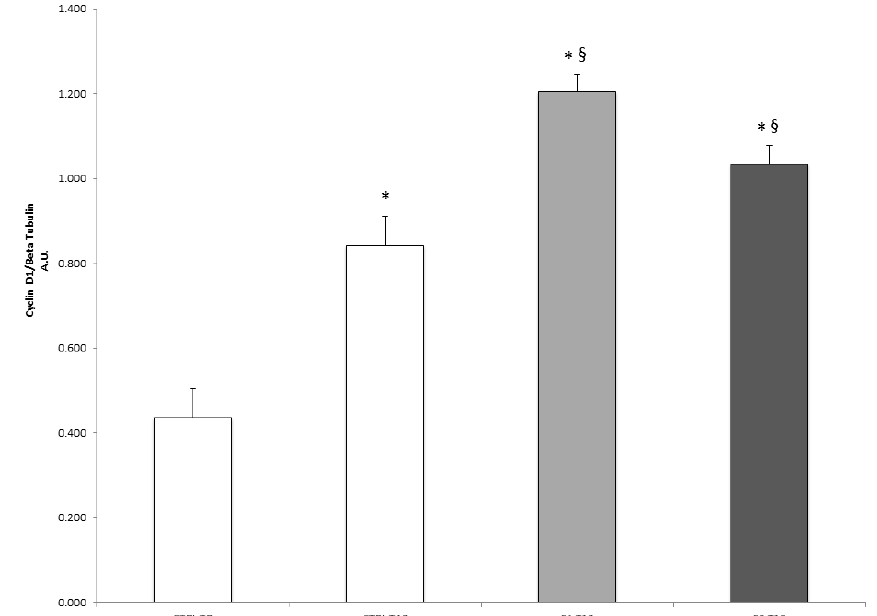
Figure 4. Effect of S1 and S2 on the proliferative marker cyclin D1 in HCEpiC cells. The graph shows the cyclin D1 protein levels in HCEpiC cells treated with S1 or S2 for 12 h. Data are means ± SD of triplicate. * indicates statistically significant difference from untreated control at 0 h; § indicates statistically significant difference from untreated control at 12 h (one-way ANOVA, p < 0.05).